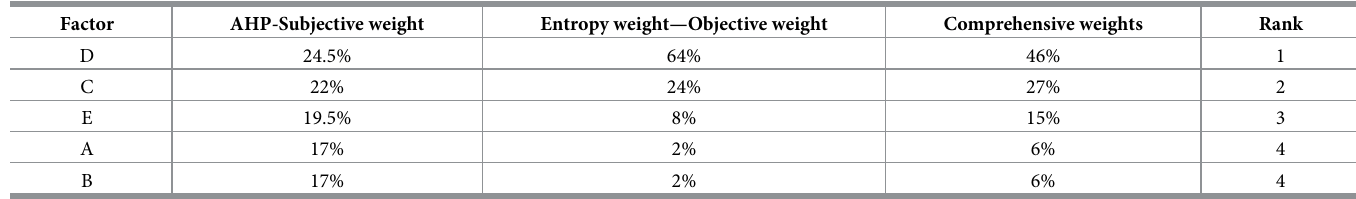
Table 6. Sort table of importance. Factor AHP-Subjective weight Entropy weight—Objective weight Comprehensive